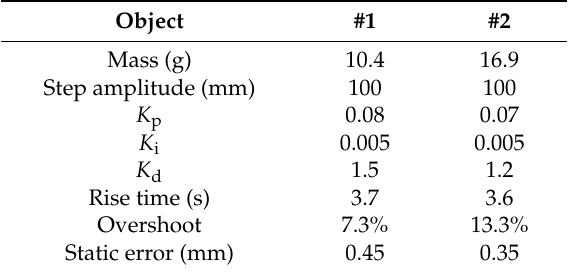
Figure 17. Simulated and experimental results for step response. Table 1. Step response performance of the PID controller.